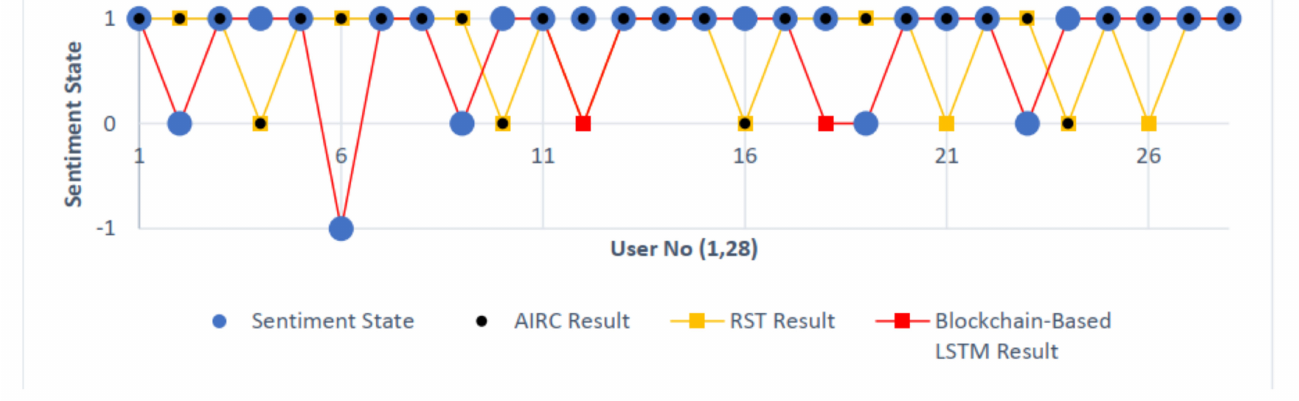
Figure 14. Sentiment state and all analysis